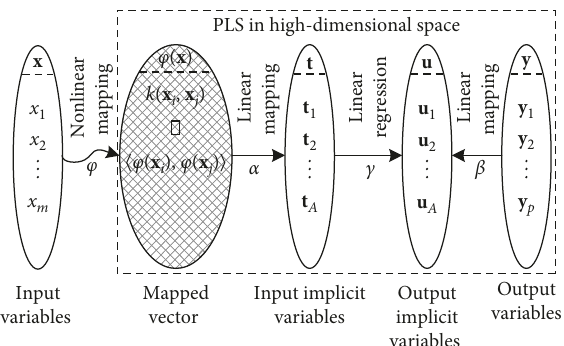
Figure 1: KPLS simulation of a complicated nonlinear